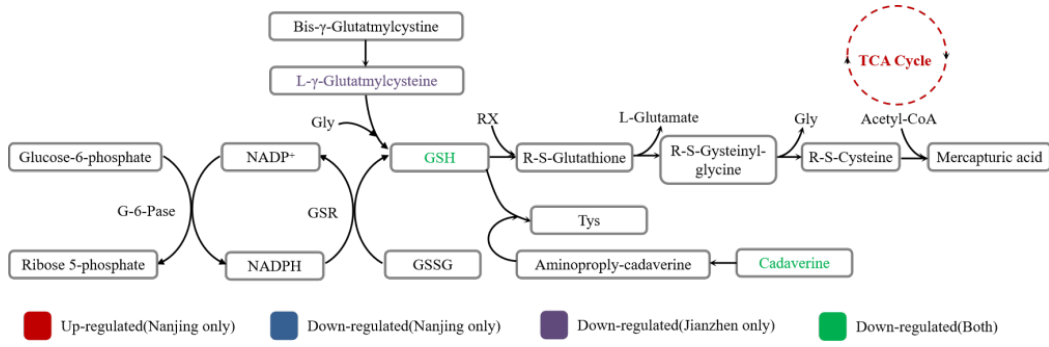
Figure 7. Changes in glutathione metabolic pathway of two varieties.